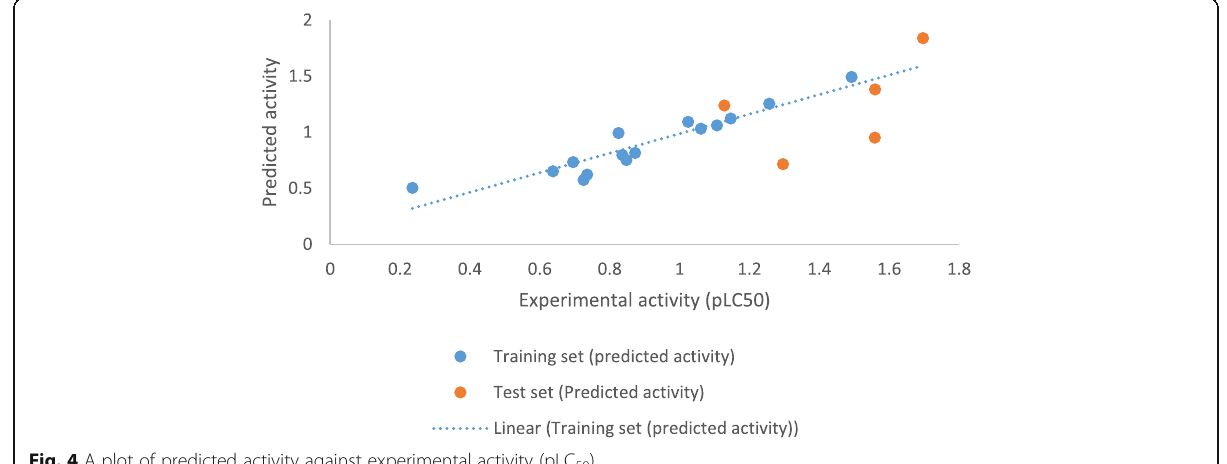
Fig. 4 A plot of predicted activity against experimental activity (pLC 50